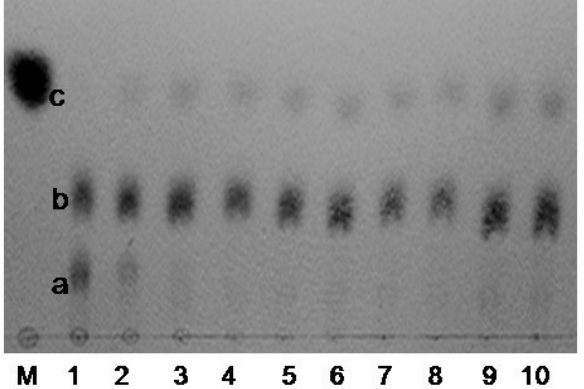
Figure 7. HPLC ( A ) and MSI-TOF-MS ( B – D ) analysis of the κ-carrageenase